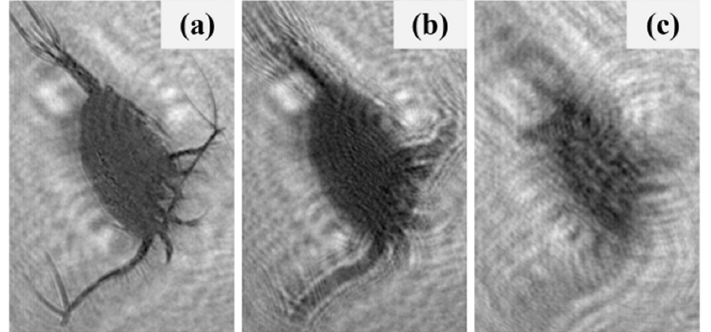
Figure 9. The SOL_VAR, TENG and MTI algorithms were used to extract plankton images. Get ( a ), ( b ) and ( c ), respectively.